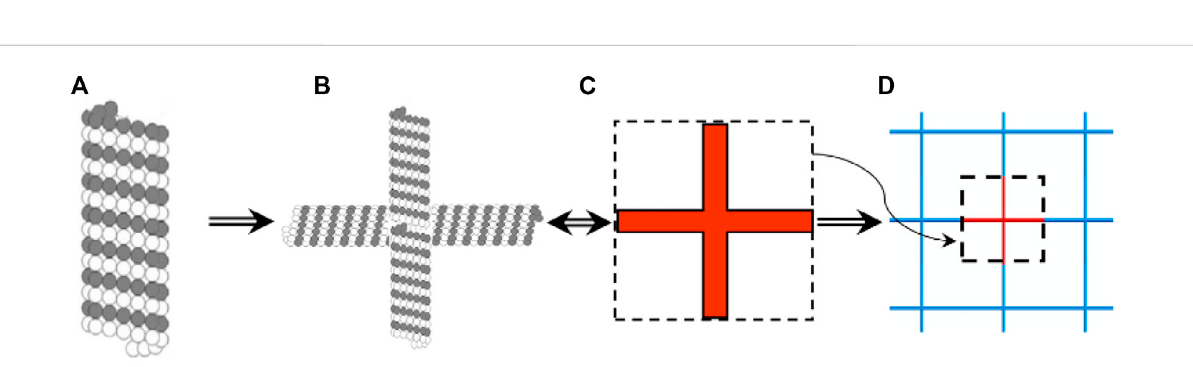
FIGURE 6 From single microtubule to periodic architected structure. Reprinted from [27] with permission. (A) Microtubule structure, (B) Two perpendicular microtubule structure, (C) Square unit cell microtubule, (D) 2-D periodic architected structure.